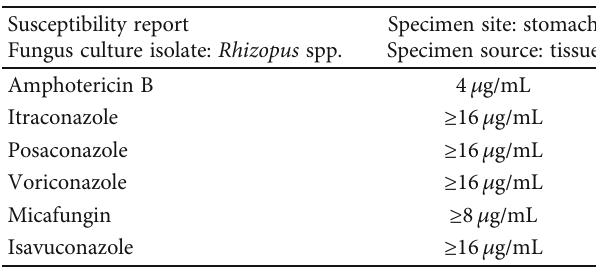
Table 4: Patient 2